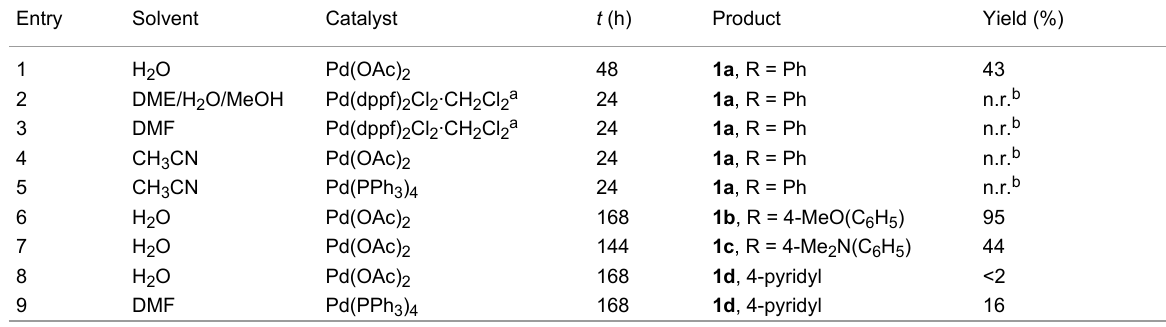
Table 1: Reaction conditions for the synthesis of 9-arylbenzo[ b ]quinolizinium derivatives 1a–d according to Scheme